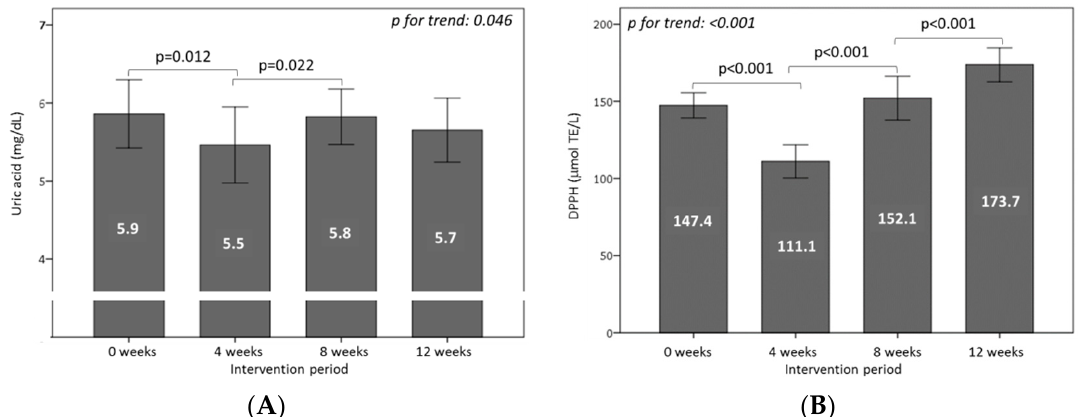
Figure 3. Effect of the consumption of burgers on ( A ) uric acid and ( B ) antioxidant capacity in plasma throughout the study. Volunteers consumed one WGPF-burger daily between weeks 0 and 4 (intervention period), followed by a washout period (weeks 4 to 8), and then consumed one control-burger daily between weeks 8 and 12 (control period). Bars represent the mean value for each time; lines represent the 95% confidence interval. Analysis of variance (ANOVA) of four repeated measures with the repeated contrast method was used to evaluate changes between the 4-week intervention periods over time. DPPH: 2,2-diphenyl-1-picrylhydrazyl; TE: Trolox ® equivalent.